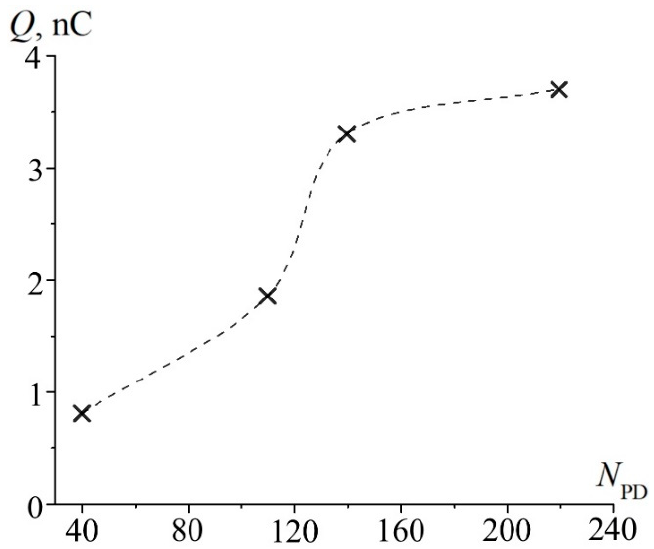
Figure 6. Dependence of the total charge Q on the number of VLPDs.